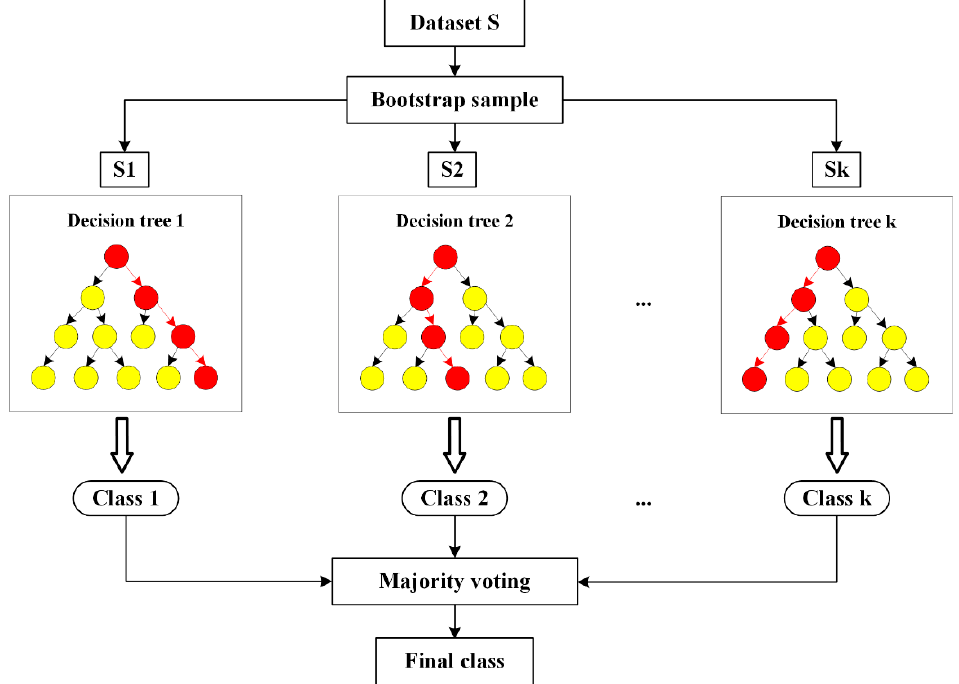
Figure 7. Illustration of the random forest classification model.